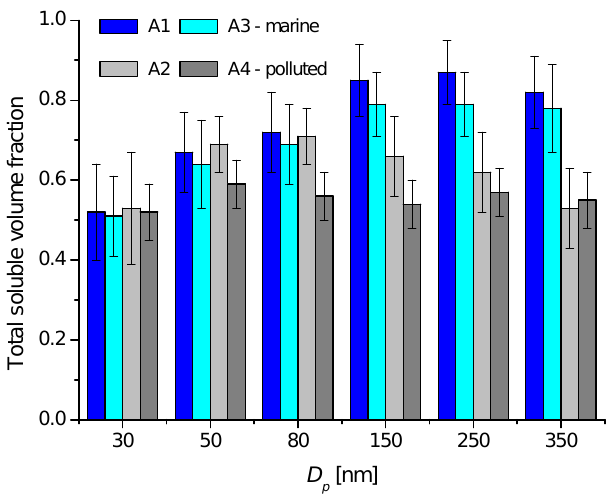
Fig. 7. Mean soluble volume fraction ε tot — based on the simplistic two-component model assuming insoluble matter and ammonium sulphate only (Sect. 3.2.1), as a function of particle size and air mass. Error bars indicate standard deviations of the